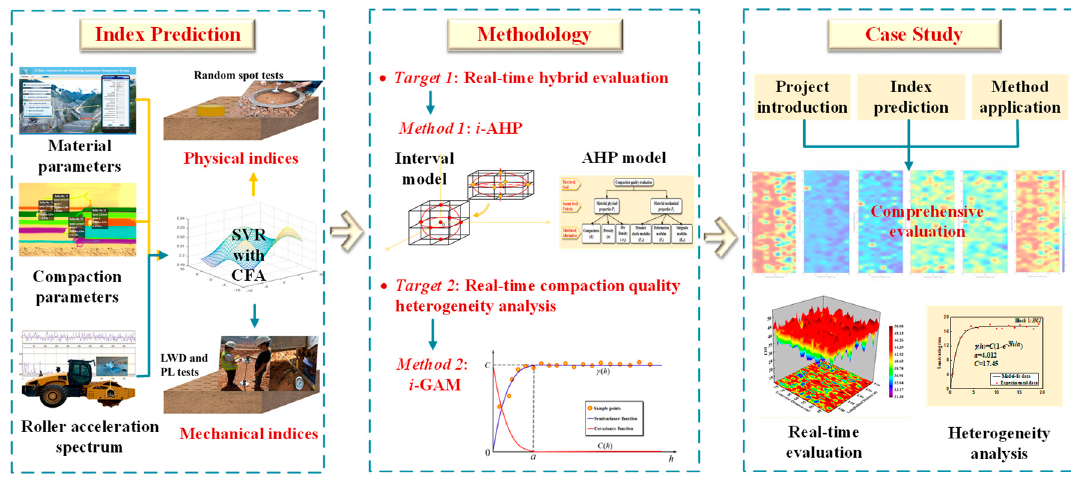
Figure 1. Research framework.